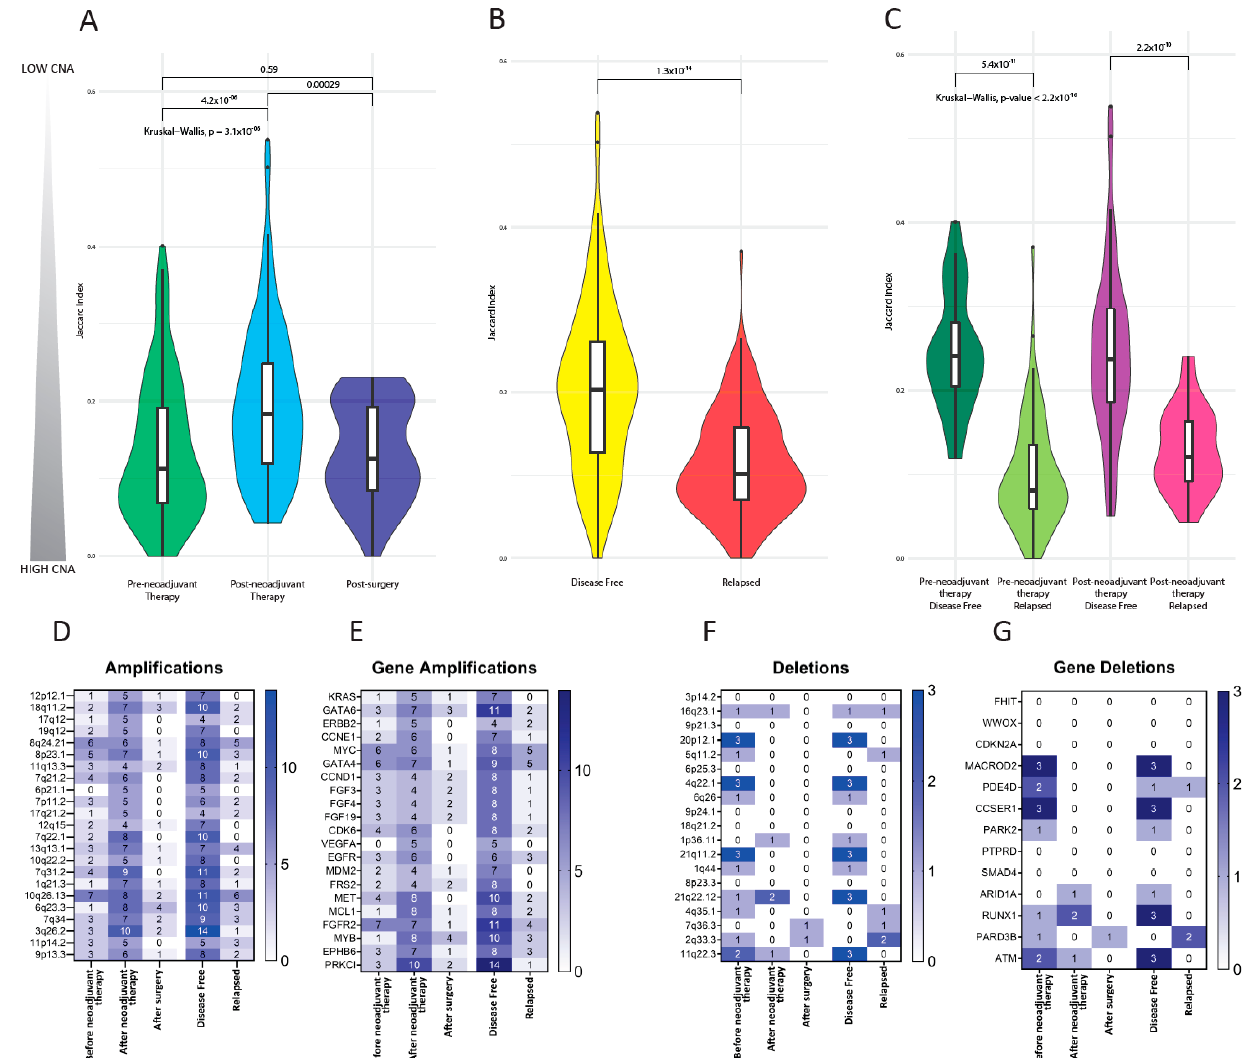
Figure 4. CTC genomic imbalance is measured relative to a matched diploid genome using a Jaccard similarity index (JI) between the set of CNAs present in the CTC and those in the patient’s leukocytes. A high JI value (max 1) indicates that the CTC’s genome has a similar CNA profile to that of matched leukocytes, a small JI value (min 0) indicates a CTC’s genome with a CNA profile that differs from that of the matched leukocytes. JI values close to zero indicate increasing genomic imbalance. ( A ) violin plot representing the distribution of CTC’s JI for cells grouped based on time point of blood draws, pre-neoadjuvant therapy ( n = 20) (green) post-neoadjuvant therapy ( n = 27) (blue) post-surgery ( n = 10) (violet). ( B ) violin plot representing the distribution of CTC’s JI for cells grouped based on patients’ clinical outcomes: disease free ( n = 28) (yellow) relapsed ( n = 29) (red). ( C ) violin plot representing the distribution of CTC’s JI for cells grouped based on a combination of time point and patient’s clinical outcomes: pre-neoadjuvant therapy of disease free patients ( n = 5) (dark green) and of relapsed patients ( n = 15) (light green); post-neoadjuvant therapy of disease free patients ( n = 14) (purple) and of relapsed patients ( n = 13) (pink). At the top, we report the p -values of Kruskal–Wallis and Wilcoxon tests. Panel of known esophageal cancer (EC) specific focal copy number changes which we found in identified CTCs. Frequently amplified regions ( D ), genes included within amplified regions ( E ), frequently deleted regions ( F ) and genes included in deleted regions ( G ). CTCs are grouped based on the time point of blood draws and patients’ clinical outcomes. The absolute frequency of CTCs bearing a specified focal copy number change is represented by a number and on a color scale. CTC: circulating tumor cells; CNA: copy number